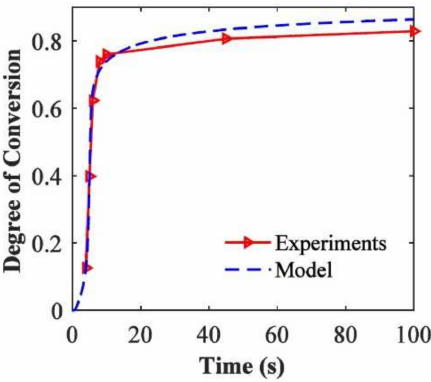
Figure 20. Degree of conversion versus reaction time for free-radical photopolymerization of PEGDA. Reprinted from reference [82] with permission of